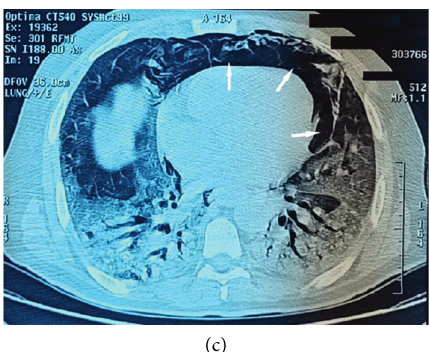
Figure 2: (a, b, c) Chest CTscan showing ground-glass opacities with crazy paving of mixed topography, bilateral to lower predominance with a degree of critical involvement > 75% classified CORADS 5 and a large abundance of spontaneous